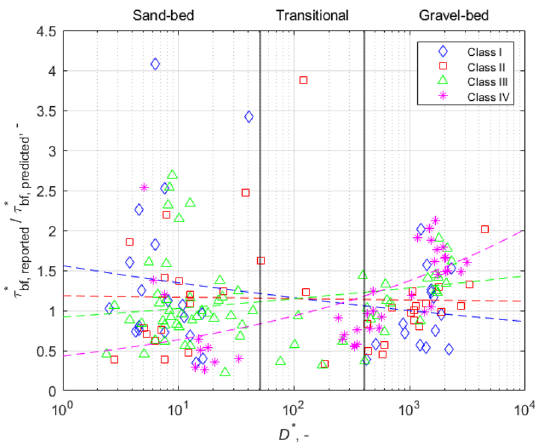
Figure 2. Fitted correction relations for the four woody vegetation cover density classes. The color scheme for the symbols is the same as Fig.